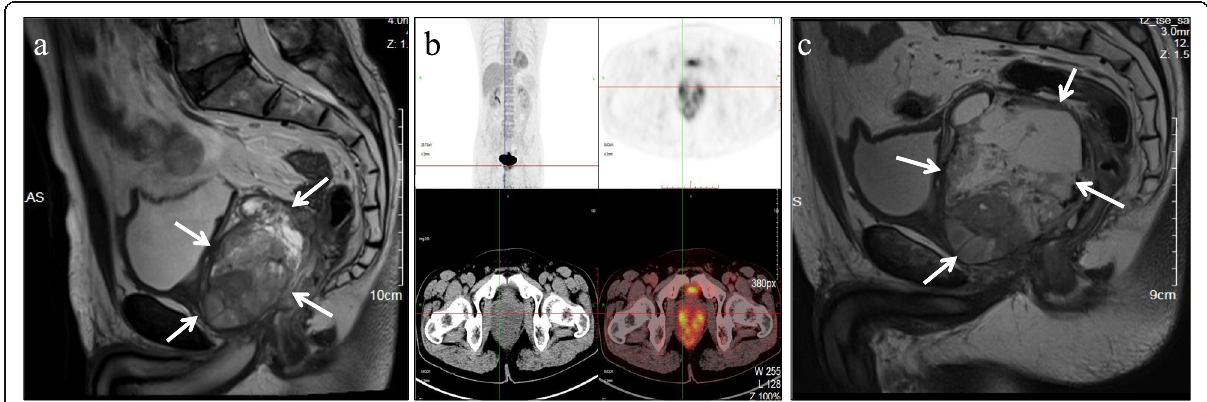
Fig. 1 Imaging features of ARID1A deficient undifferentiated spindle cell and rhabdoid sarcoma of the prostate. ( a ) Magnetic resonance imaging (MRI) revealing a large, ill-defined, prostatic mass lesion with circumferential extension into the rectal wall ( as indicated by arrows ). ( b ) Positron emission tomography-computed tomography scan showing a mixed mass of the prostate with an uneven increase in fluorodeoxyglucose metabolism. ( c ) MRI showing that the prostatic tumor is significantly enlarged with central areas of hemorrhage, necrosis and cystic change ( as indicated by arrows ), after 2 months of chemotherapy with etoposide and cisplatin